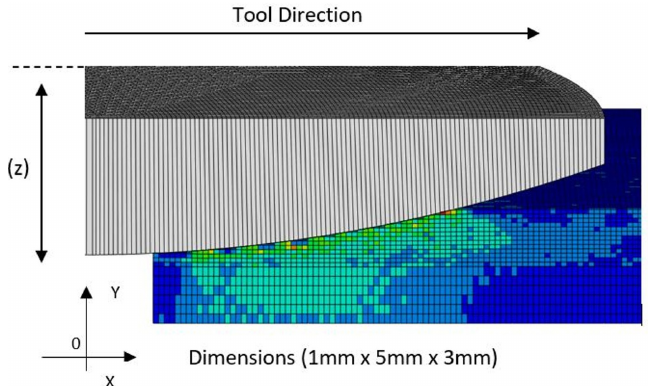
Figure 7. 2D Cross section of the 3D FE